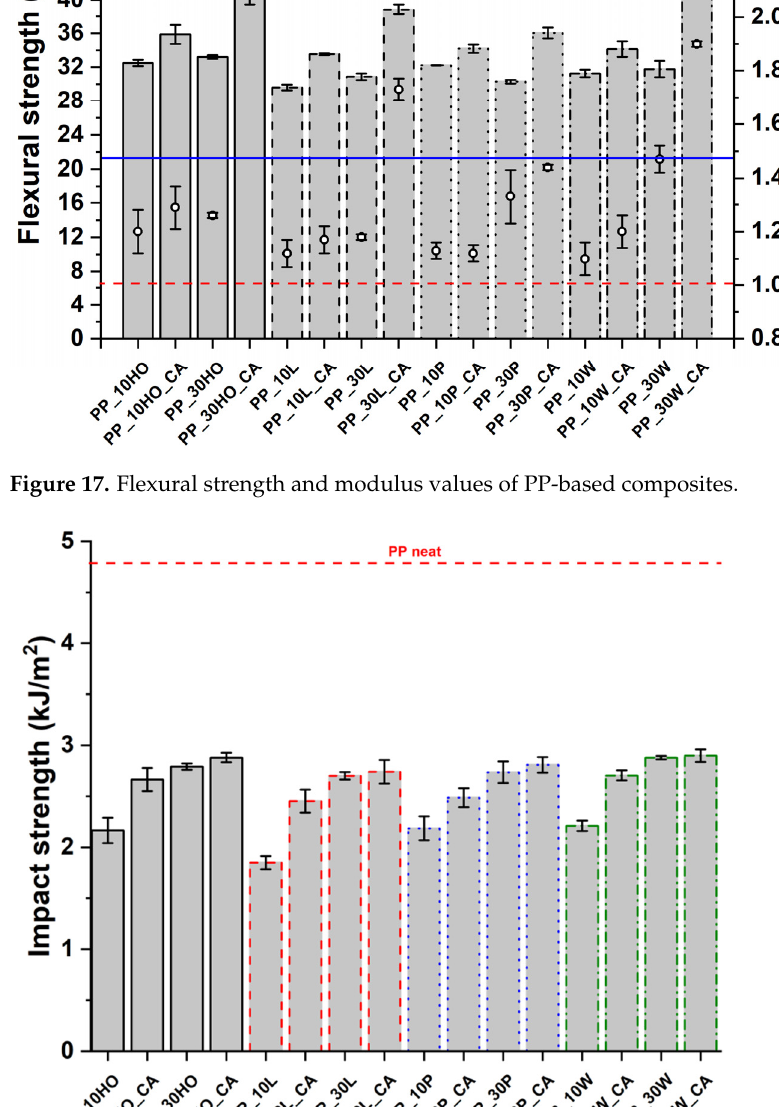
Polymers 2022 , 14 , x FOR PEER REVIEW 21 of 27